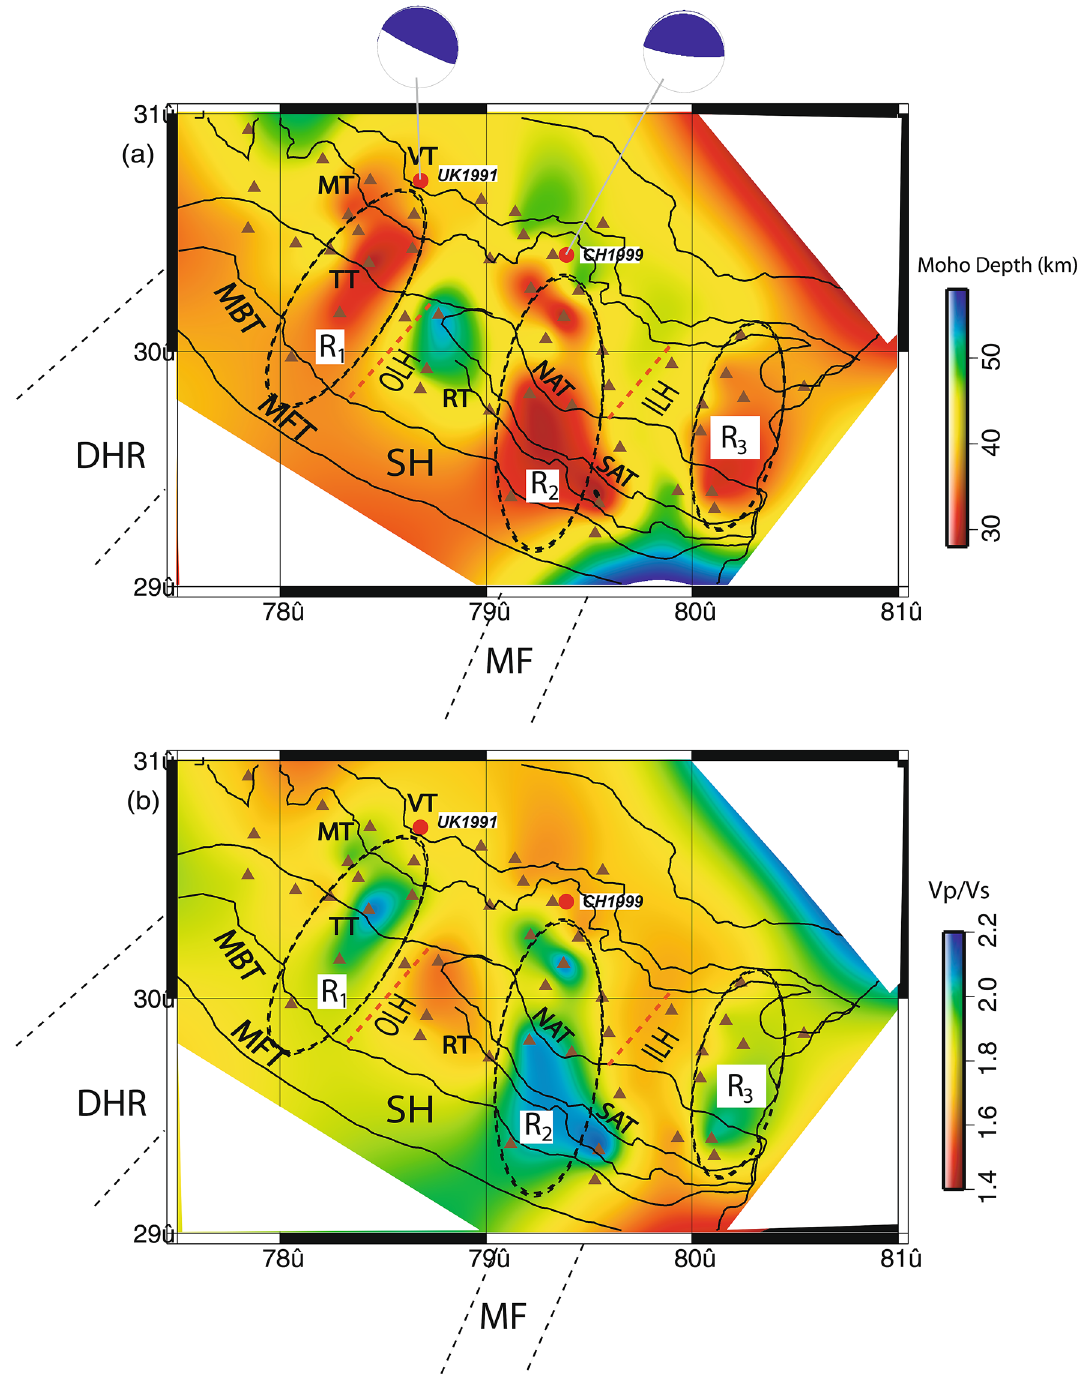
Figure 4. Modelled lateral variations of ( a ) Moho (in km. Black filled triangles show broadband seismic stations. The locations of the 1991 Uttarkashi (M w 6.6) and 1999 Chamoli (M w 6.4) earthquakes are shown by large filled red circles. The focal mechanism solutions of these two earthquakes are also shown by beach balls. Solid grey circles mark relocations of local Himalayan events, and ( b ) average crustal Vp/Vs. DHR marks the inferred NE extension of the Delhi-Haridwar basement ridge while MF represents a NE striking inferred Moradabad fault 23 . Black dotted elliptical zones mark the mapper transverse features (N to NE trending). Major thrusts (shown by black lines): VT Vaikrita Thrust, MT Munsiari Thrust, TT Ton Thrust, RT Ramgarh Thrust, NAT North Almora Thrust, SAT South Almora Thrust, MBT Main Boundary Thrust, MFT Main Frontal Thrust. SH marks the Siwalik Himalaya. ILH marks the inner lesser Himalaya while OLH marks the outer lesser